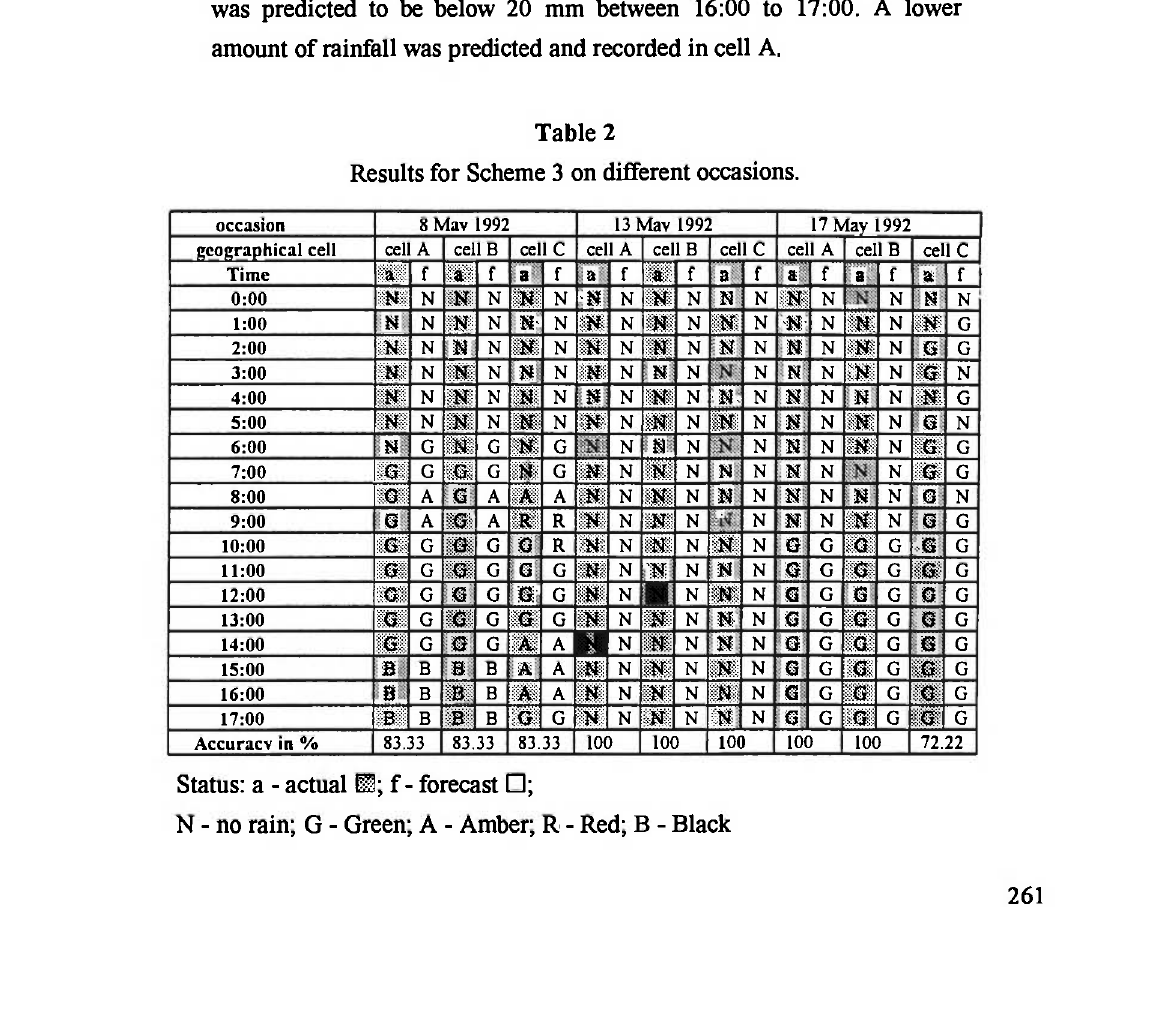
Results for Scheme 3 on different